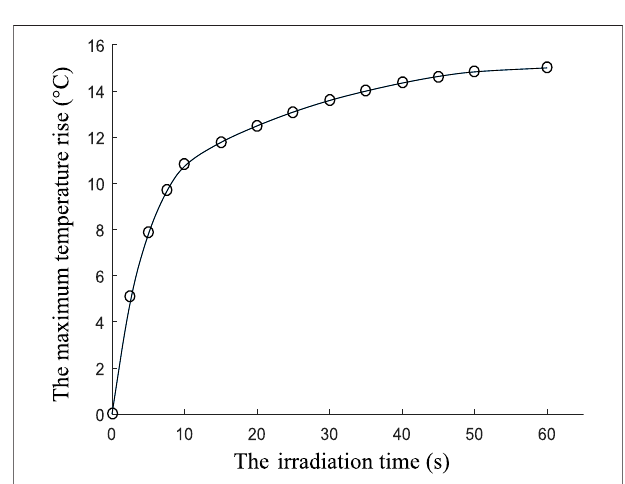
FIGURE 10 | In fl uence of different irradiation times on the maximum temperature rise.